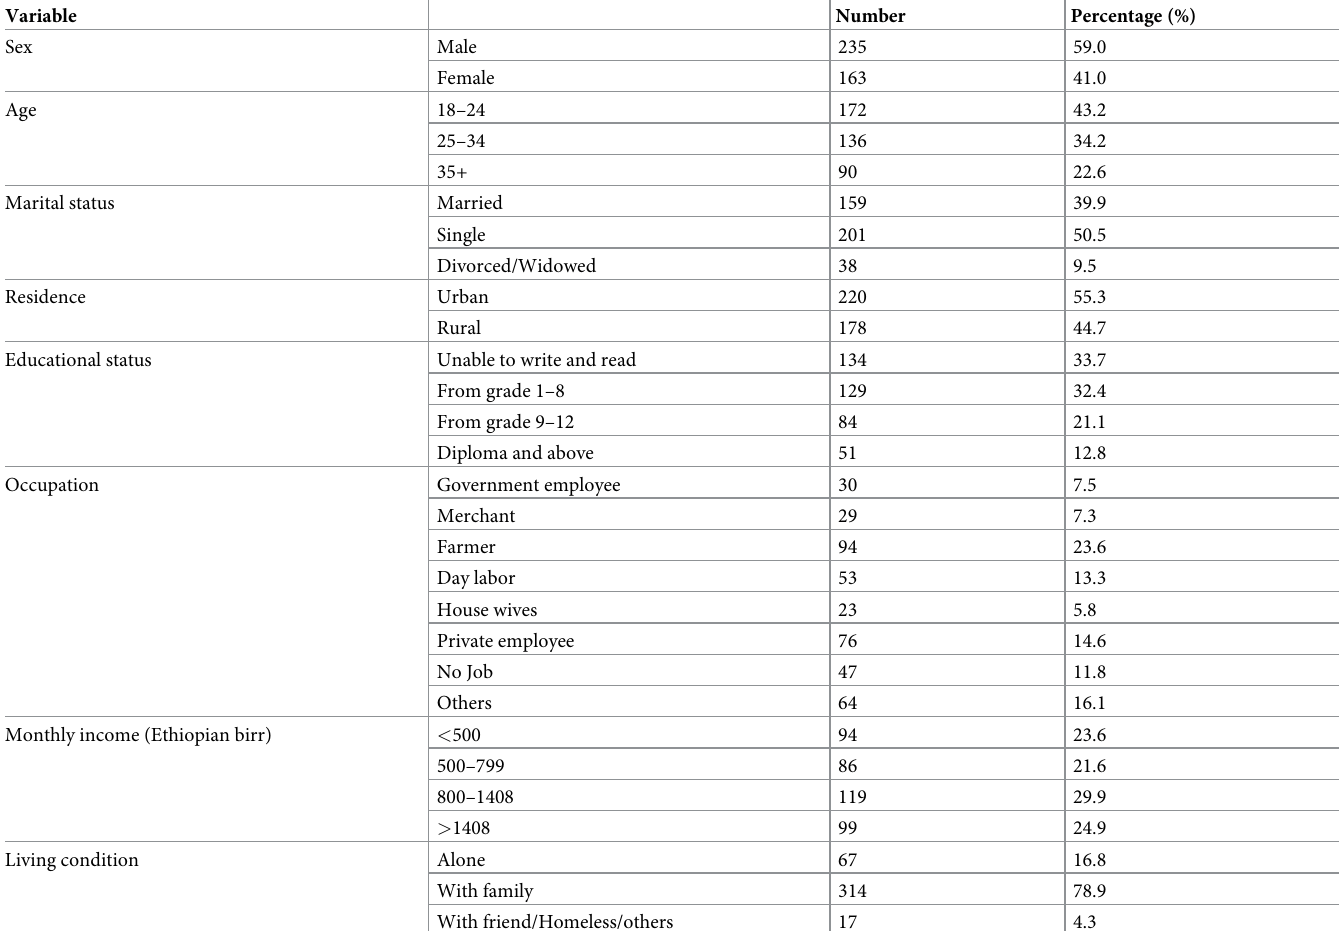
Table 1. Distribution of participants by socio-demographic characteristics at government health institution in Bahir Dar City, 2017(n = 398).